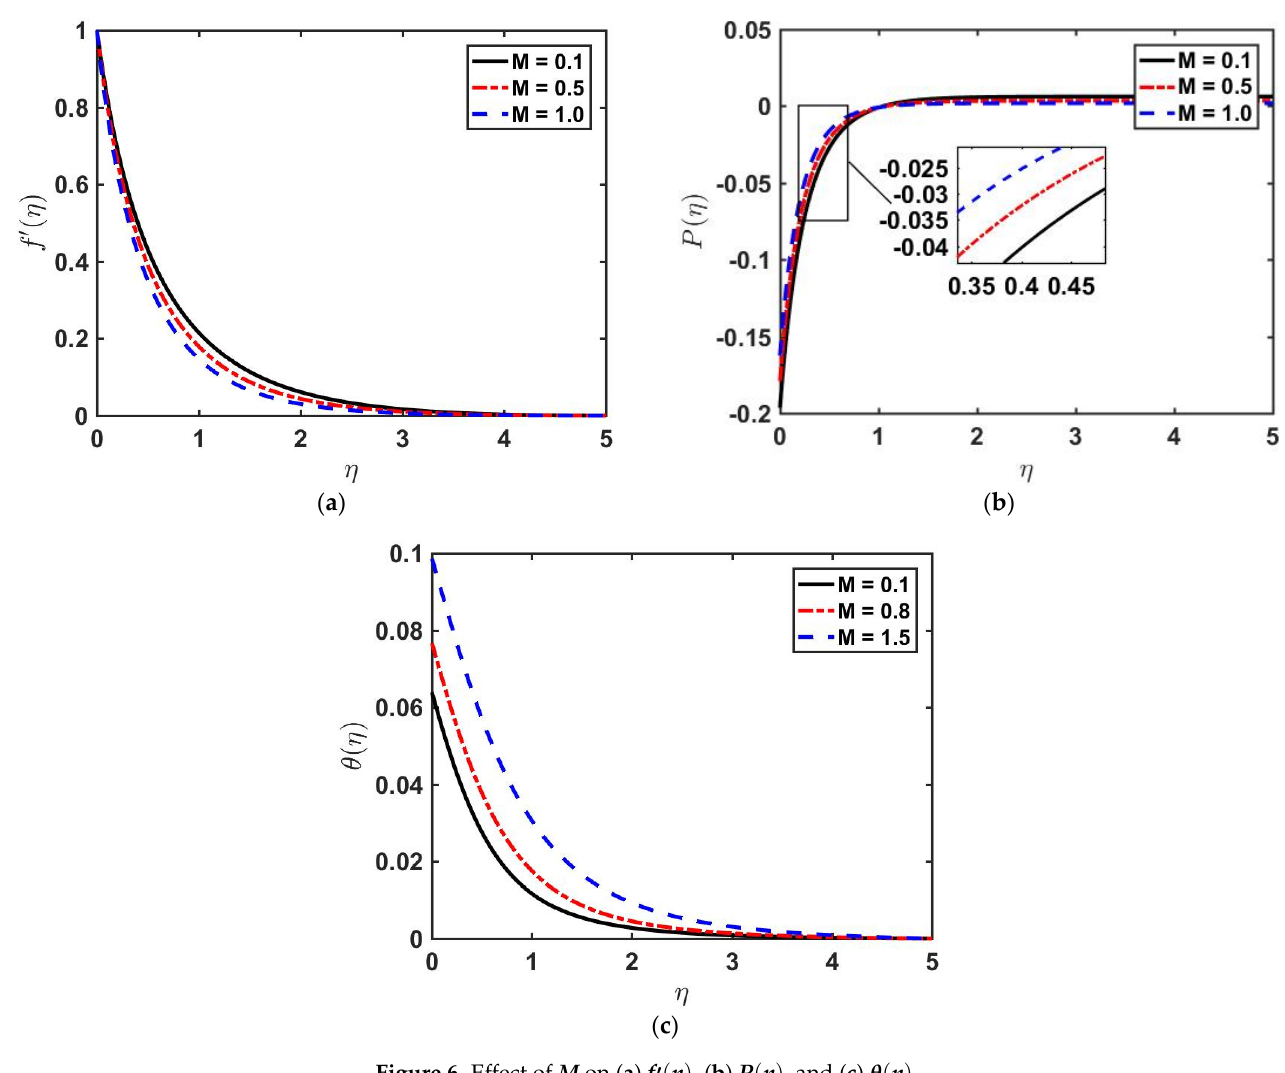
Figure 8. Effect of 𝑹𝒅 on 𝜽(𝜼) . Figure 9a,b show the effect of irregular heat parameters on heat distribution. It is observed in both figures that by enhancing the values of 𝐷 (cid:2869) and 𝐸 (cid:2869) , there is a hike in the temperature distribution. By augmented values of irregular heat factors, the fluid tem- perature shows production results in the enhancement of the heat distribution of fluid. Figure 10 portrays the impact of the Eckert number on heat convection phenomena. It is observed from the graph that by increasing the Eckert number, there is an increase in heat distribution. The Eckert factor is defined as the ratio between the kinetic energy as well as the boundary layer enthalpy. So, by augmenting the value of the Eckert number, there is a rise in the heat distribution value. Figure 11 shows the impact and significance of 𝜖 on the temperature profile 𝜃(𝜂) . As we increase 𝜖, the temperature profile also in- creases.